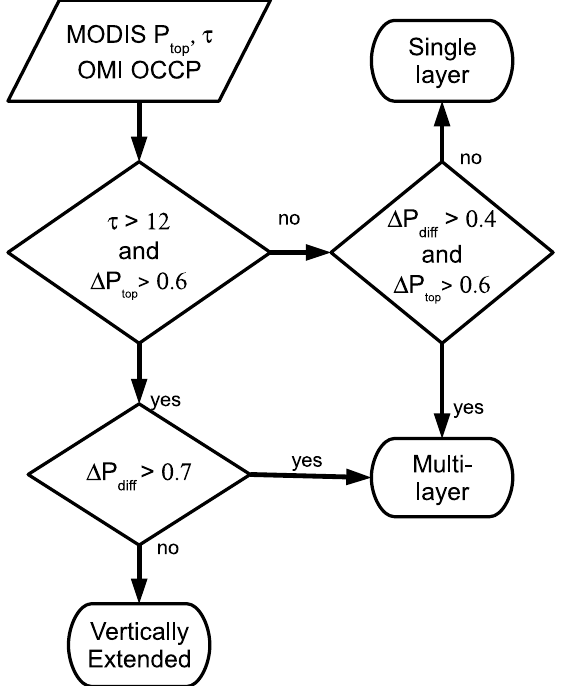
Fig. 3. Flow chart describing OMI/MODIS multi-layer/extended cloud detection scheme.